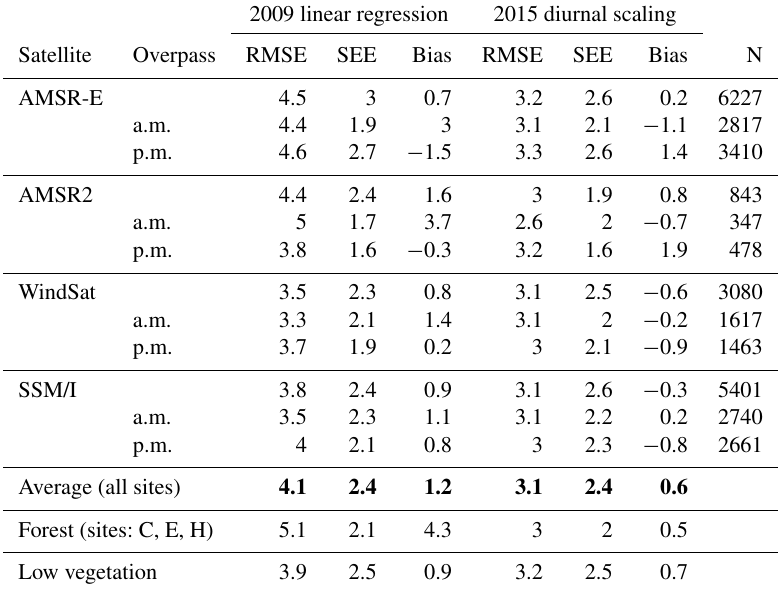
Table 4. Validation results by MW satellite (all data, a.m. or p.m. overpass), aggregated for locations A–M (see Table